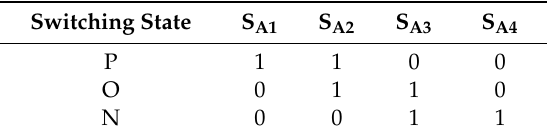
Table 1. Definition of switching states for phase A.